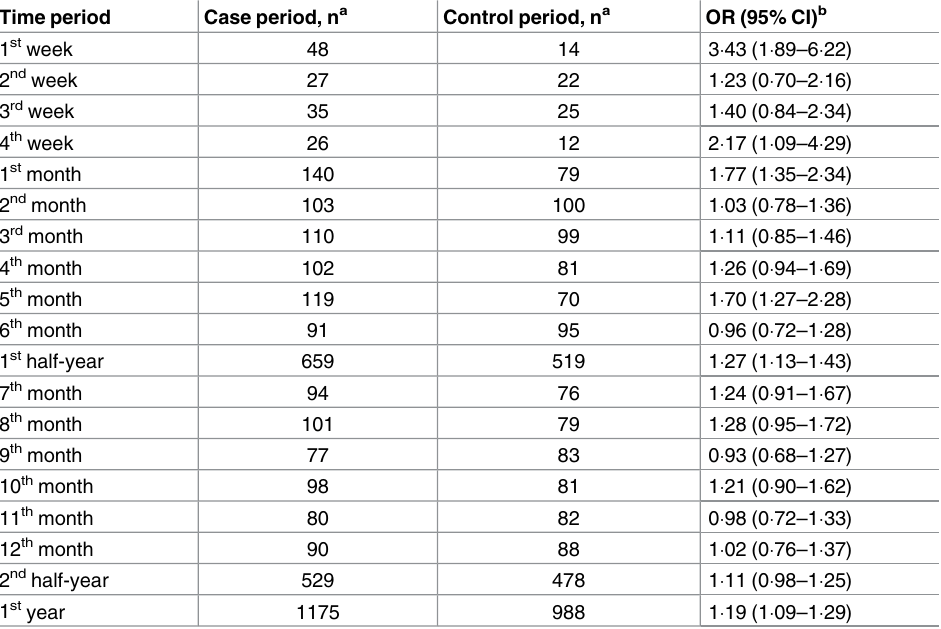
Table 1. Odds ratios (OR) and 95% Confidence Intervals (CI) of suicide within the first year after death of a close relative in 31 059 suicide victims in Sweden. Time period Case period, n